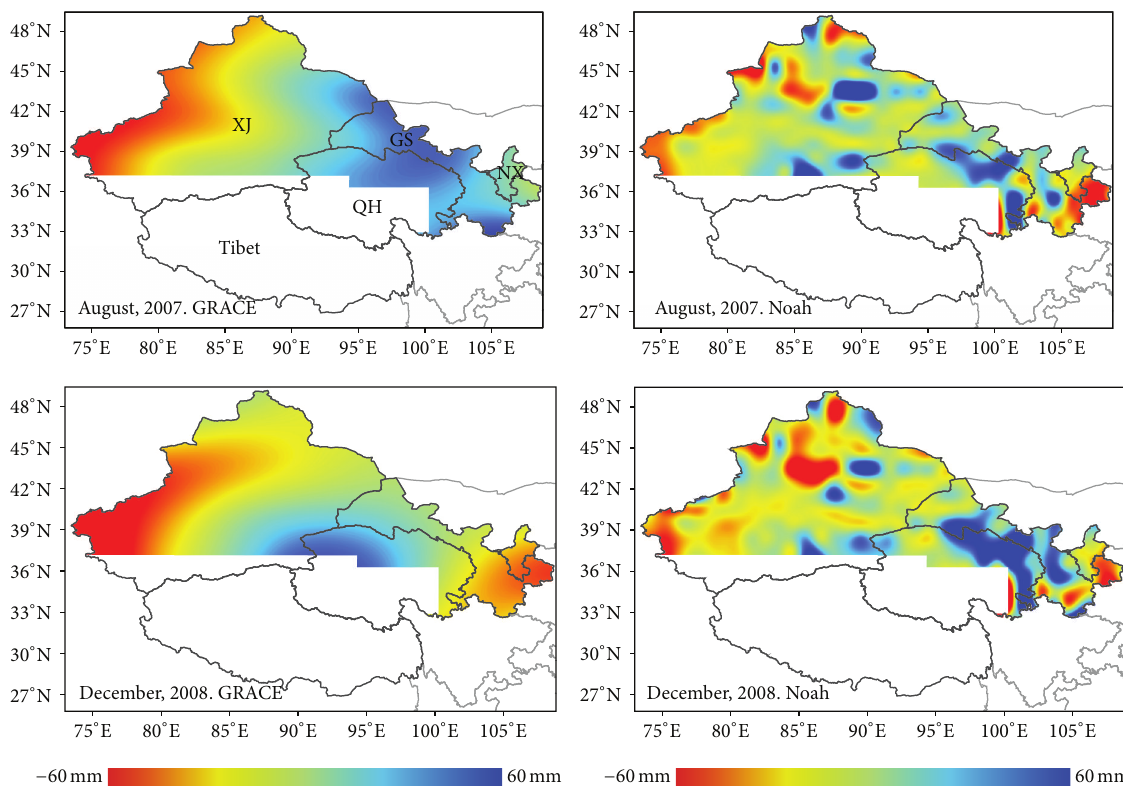
Figure 2: Results of WSC retrieved by GRACE and simulated by Noah.